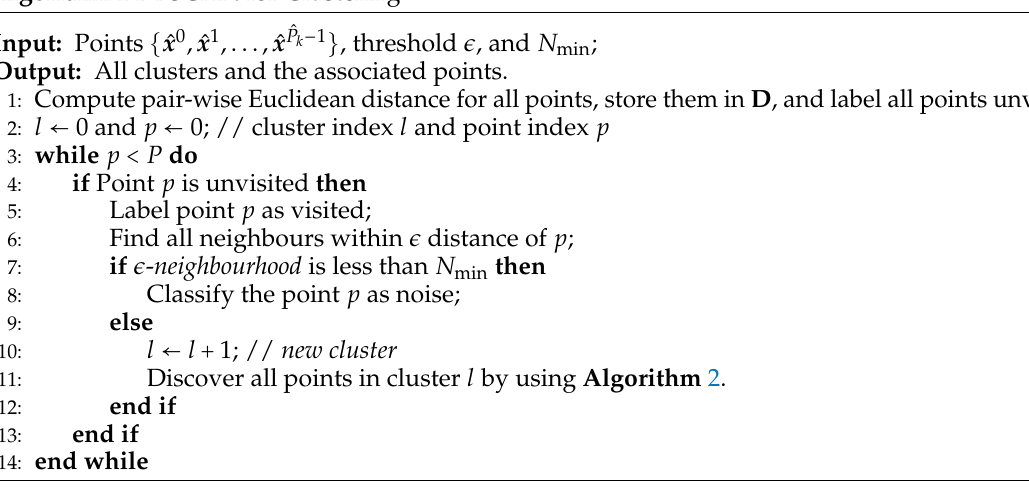
Algorithm 1 DBSCAN for Clustering